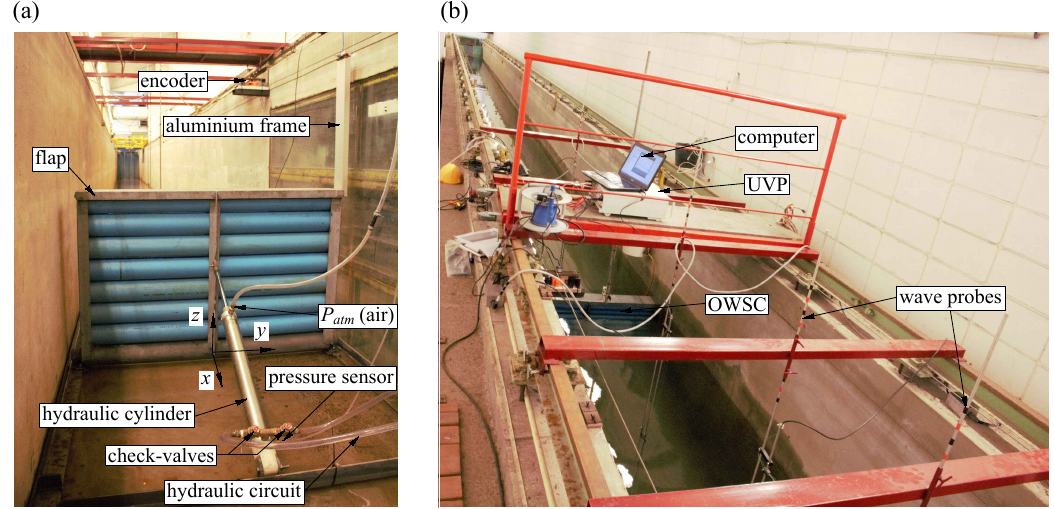
Figure 3. ( a ) OWSC model and ( b ) experimental